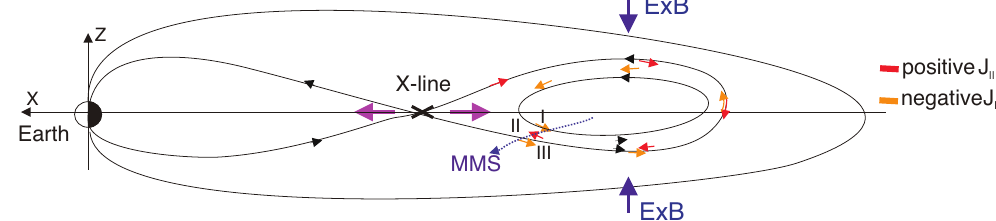
Figure 5. A cartoon of the large-scale magnetic configuration containing the observed FACs. The arrows show the direction of field-aligned electron beams producing the FACs, while the color of the arrows displays the FAC direction according to the legend in the right part of the figure. The magnetic field lines are shown by the solid black